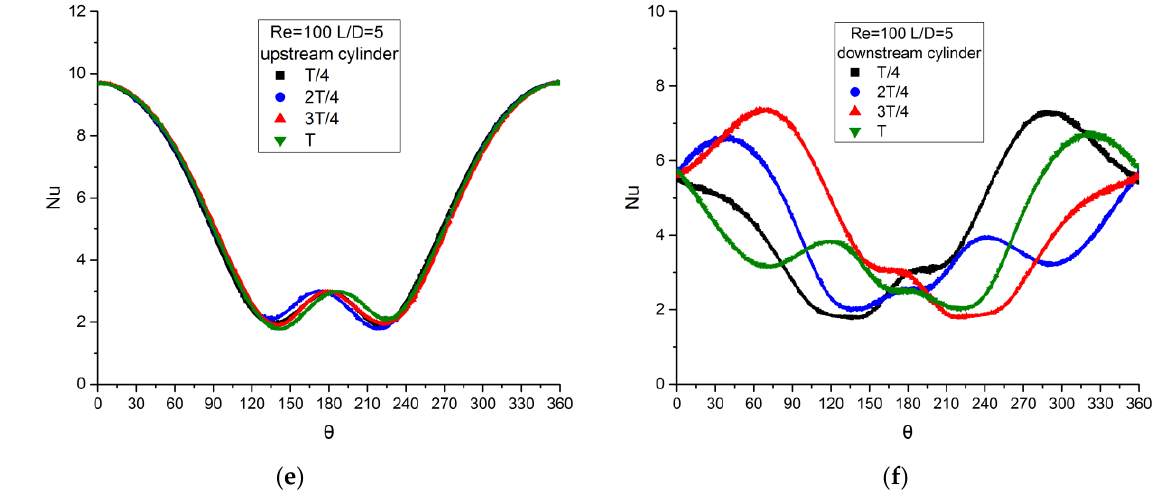
Figure 8. Transient temperature and Nusselt number distribution of the co-shedding pattern, Re = 100, L/D = 5: ( a ) 1/4 T; ( b ) 2/4T; ( c ) 3/4T; ( d ) T; ( e ) Nusselt number of the upstream cylinder; ( f ) Nusselt number of the downstream cylinder.